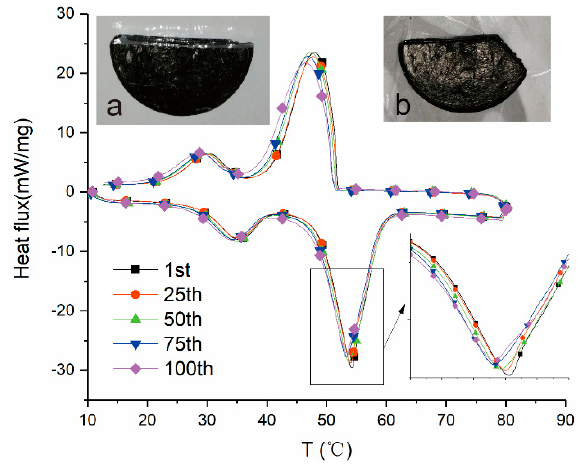
Figure 14. DSC curves of C12W5E15 after several thermal cycles (( a , b) were digital photos taken before and after 100 cycles respectively).